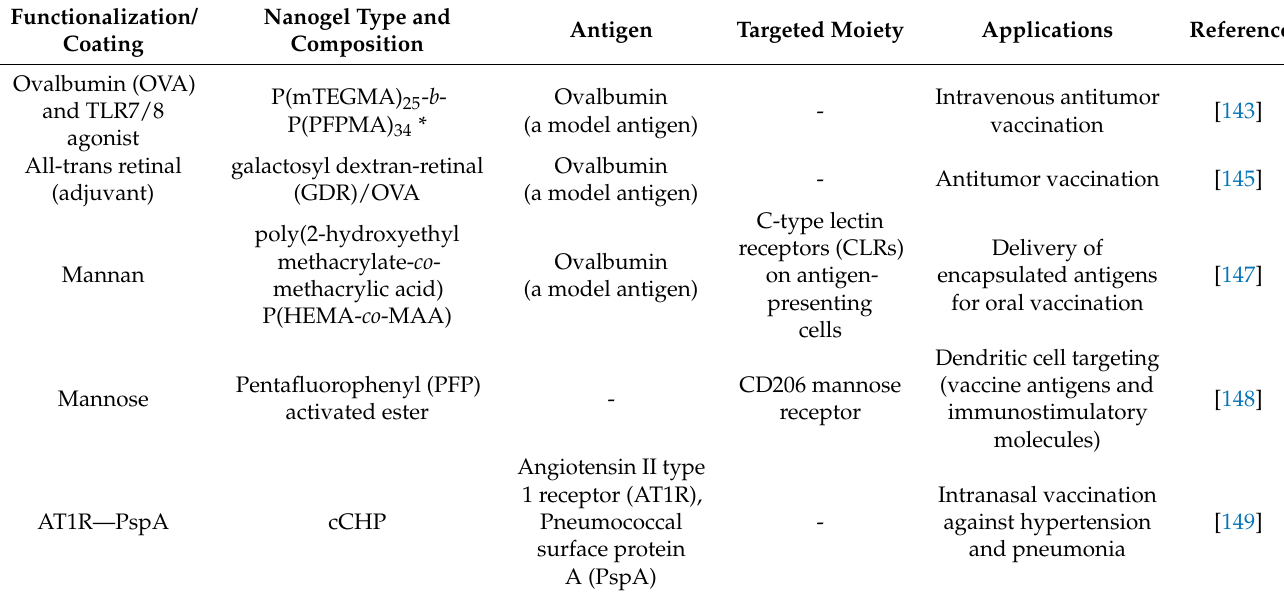
Table 3. Functionalized NGs-based approaches in